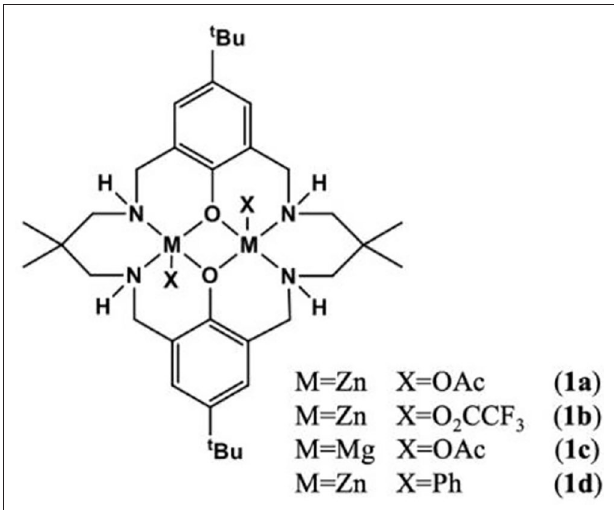
FIGURE 2 | The structures of various homodinuclear